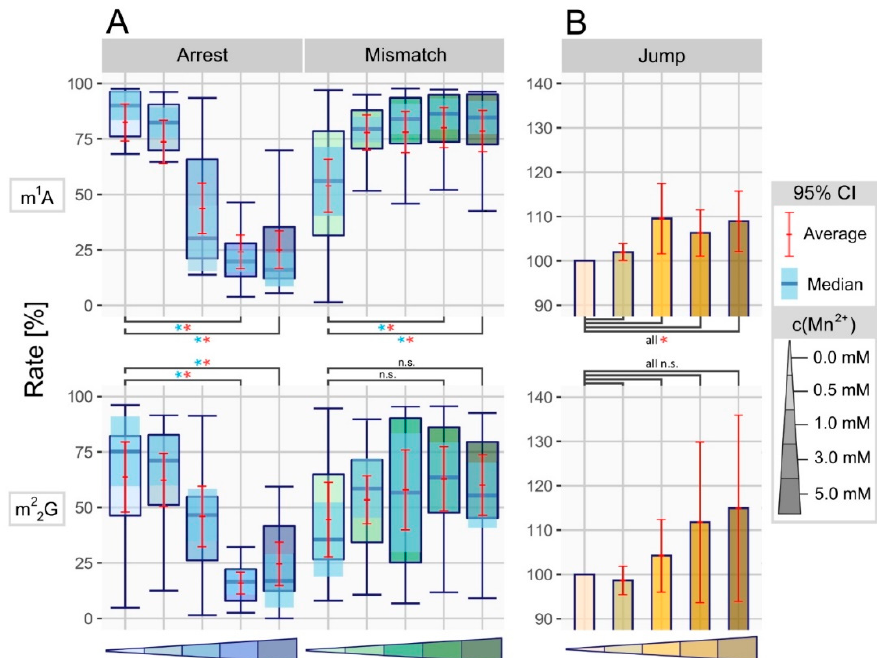
Figure 3. ( A ) Boxplot showing the RT signatures of all m 1 A and m 22 G positions in tRNA from Saccharomyces cerevisiae at differing manganese concentrations, using EpiScript RT. The triangled color palette represents increasing concentrations of Mn 2+ . The 95% confidence intervals are displayed in light blue (median) and red (average), with colored asterisk (*) indicating significant differences ( p -value < 0.05). ( B ) Normalized bar plot based on the same dataset and color code as ( A ), displaying the difference in jump rate between normalized reference and manganese treated samples.